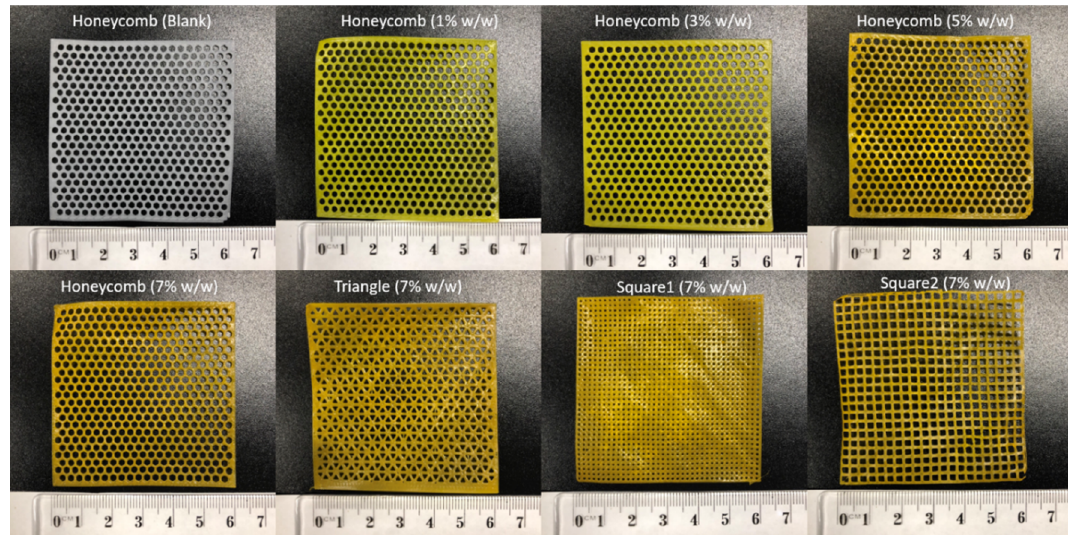
Figure 3. 3D printed blank and curcumin-loaded scaffolds (0.2 mm thickness) with different drug loadings (1%, 3%, 5%, and 7%, w / w ) and pore shape types (honeycomb, triangle, square 1, and square 2).